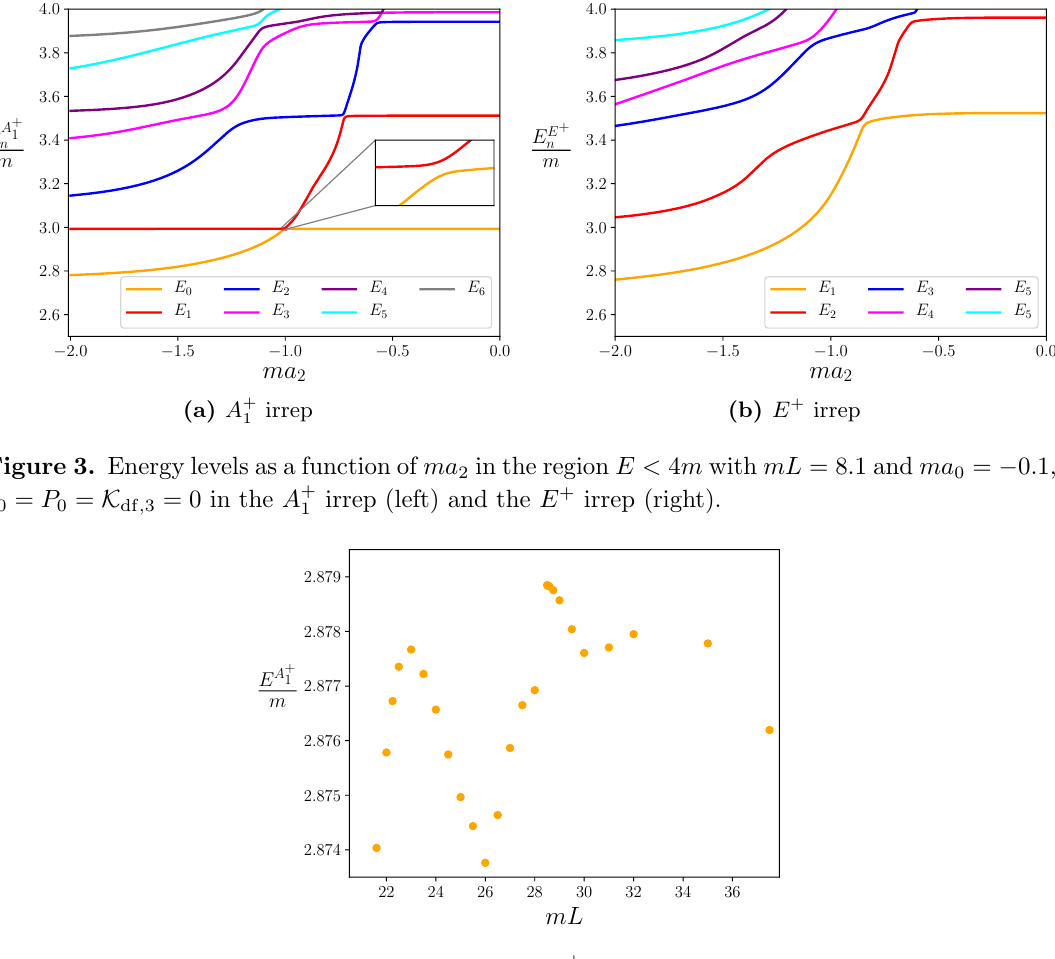
Figure 4. Energy of the subthreshold state in the A + irrep as a function of mL . The parameters 1 are ma 0 = 0 : 1, ma 2 = 1 : 3 and r 0 = P 0 = = 0. Note the highly compressed vertical scale. (cid:0) (cid:0) K df ; 3 Results for ma 2 = 1 : 3 are shown in (cid:12)gure 4. The volume dependence of the energy (cid:0)